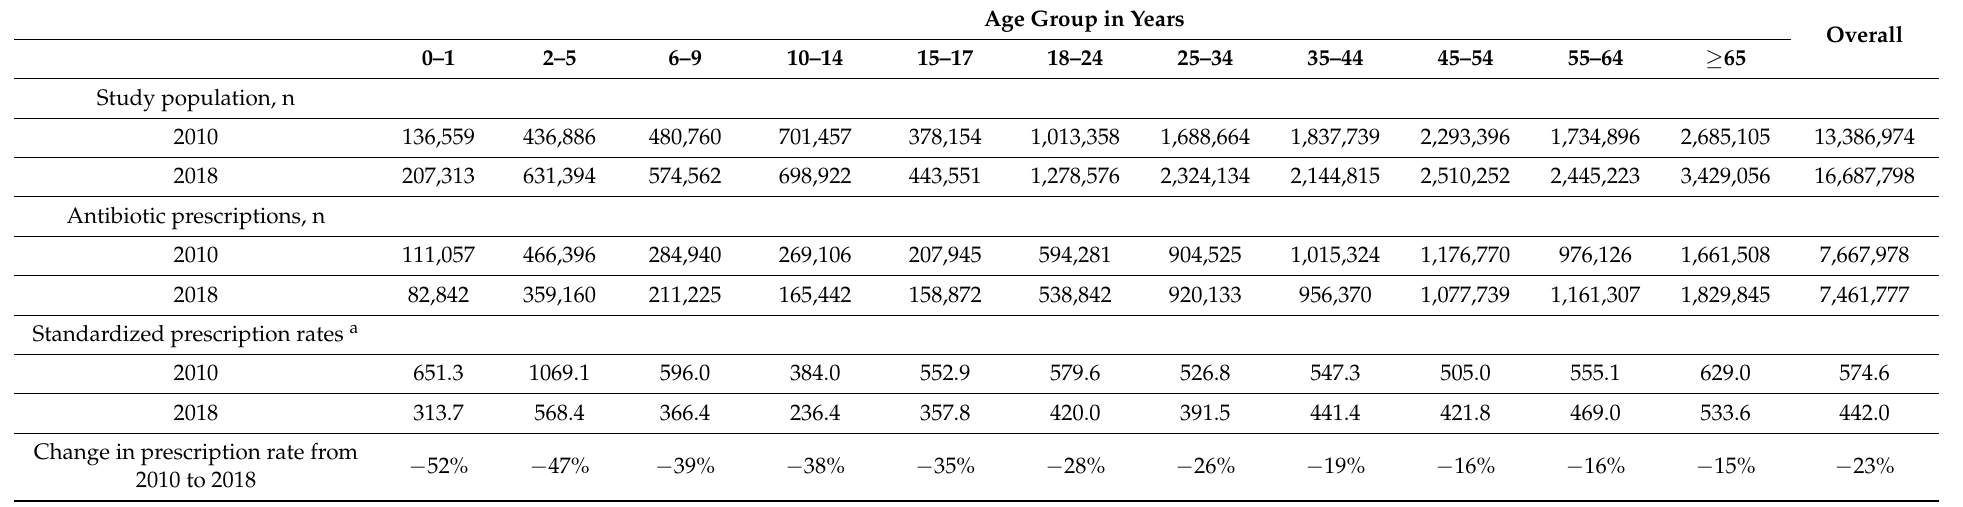
Table 1. Study population, antibiotic prescriptions, and standardized prescription rates of antibiotics in 2010 and